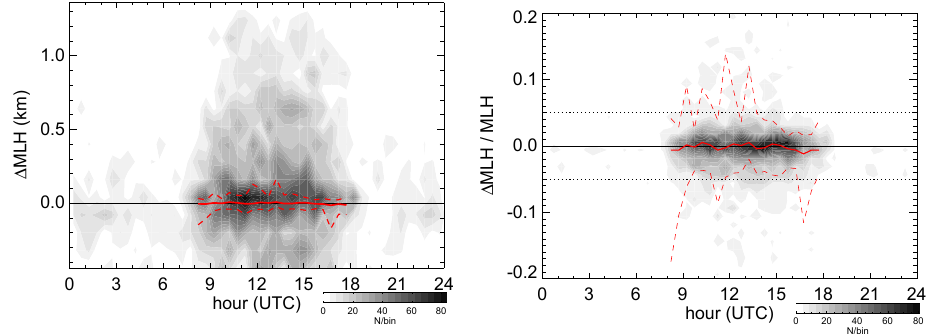
Figure 1. Absolute difference 1 MLH=MLH CT25K − MLH CHM15k (left) and relative difference 1 MLH / MLH CHM15k (right) of retrieved MLH aero from Vaisala CT25K and Jenoptik CHM15k as function of time of the day for the period 16 August–16 November 2013. Shading shows frequency of occurrence for bin sizes of 30min and 120m for absolute and 0.0125 (1.25%) for relative MLH difference respectively. Red lines are the 25 and 75% percentile (dashed) and the median (solid) of half hour intervals, respectively. For the analysis 9173 data points were used. During half hour intervals when less than 20% of the data were available (see text) median and quartiles are not displayed. Dotted lines mark ± 0.05 chosen as the average error for the MLH aero estimate.